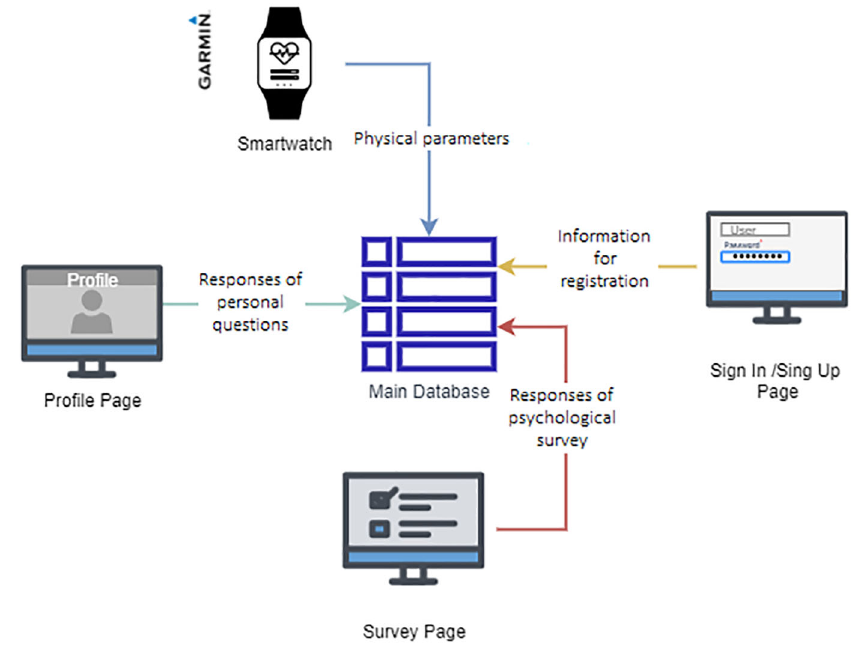
Figure 7. Composition of the